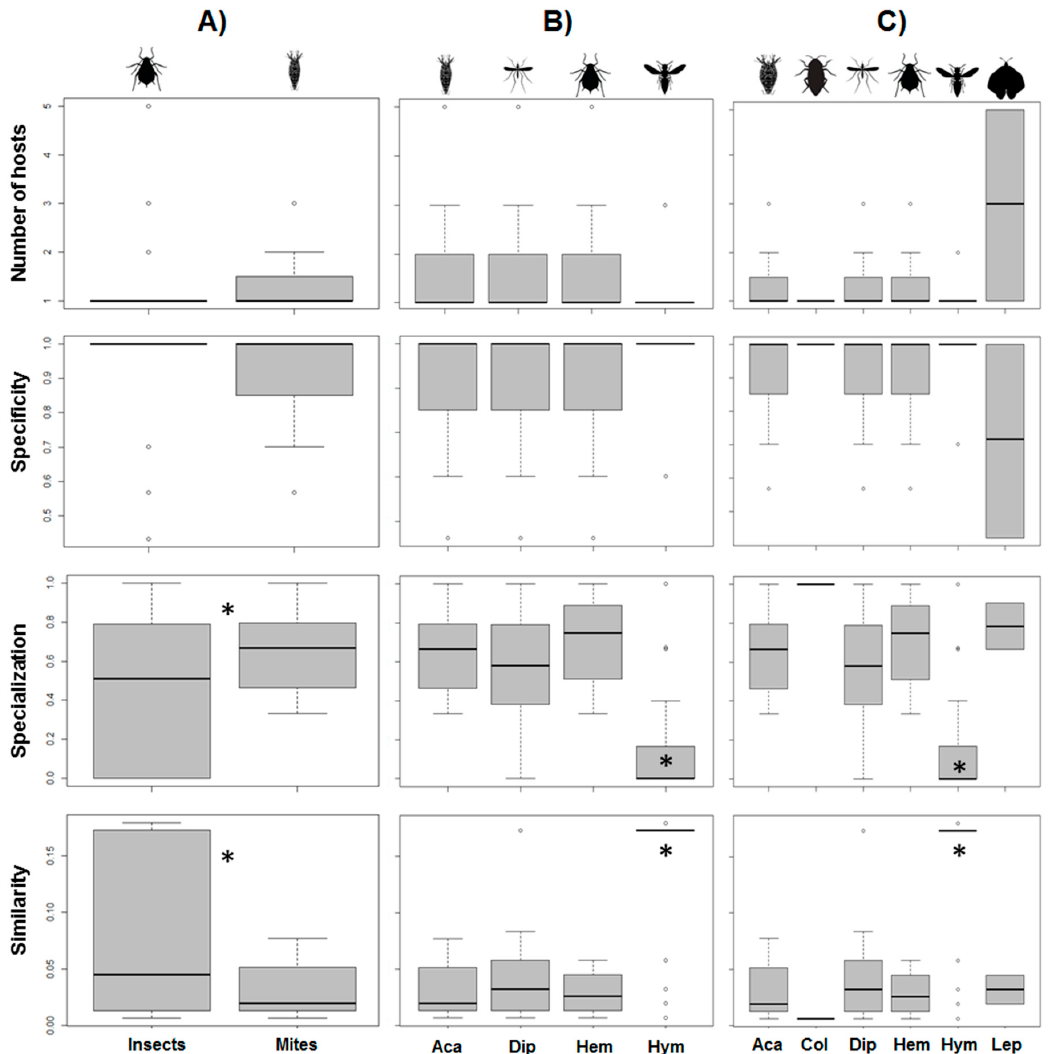
Figure 1. Comparison of the number of host plants, specialization, specificity, and similarity of plant-galling interactions of ( A ) arthropods classes (insects and mites), ( B ) arthropod orders (Acarina, Diptera, Hemiptera and Hymenoptera), and ( C ) arthropod families (Adelgidae, Aphididae, Cecidomyiidae, Cynipidae, Eryophyidae, and Tenthredinidae) in the Nitra City Park (Nitra, SW, Slovakia). Asterisks indicate significant differences (ANOVA, p < 0.05).